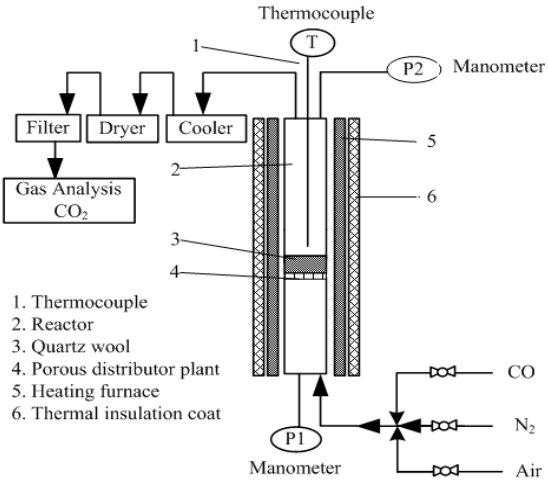
Figure 2. A schematic diagram of the fluidized-bed reactor system.